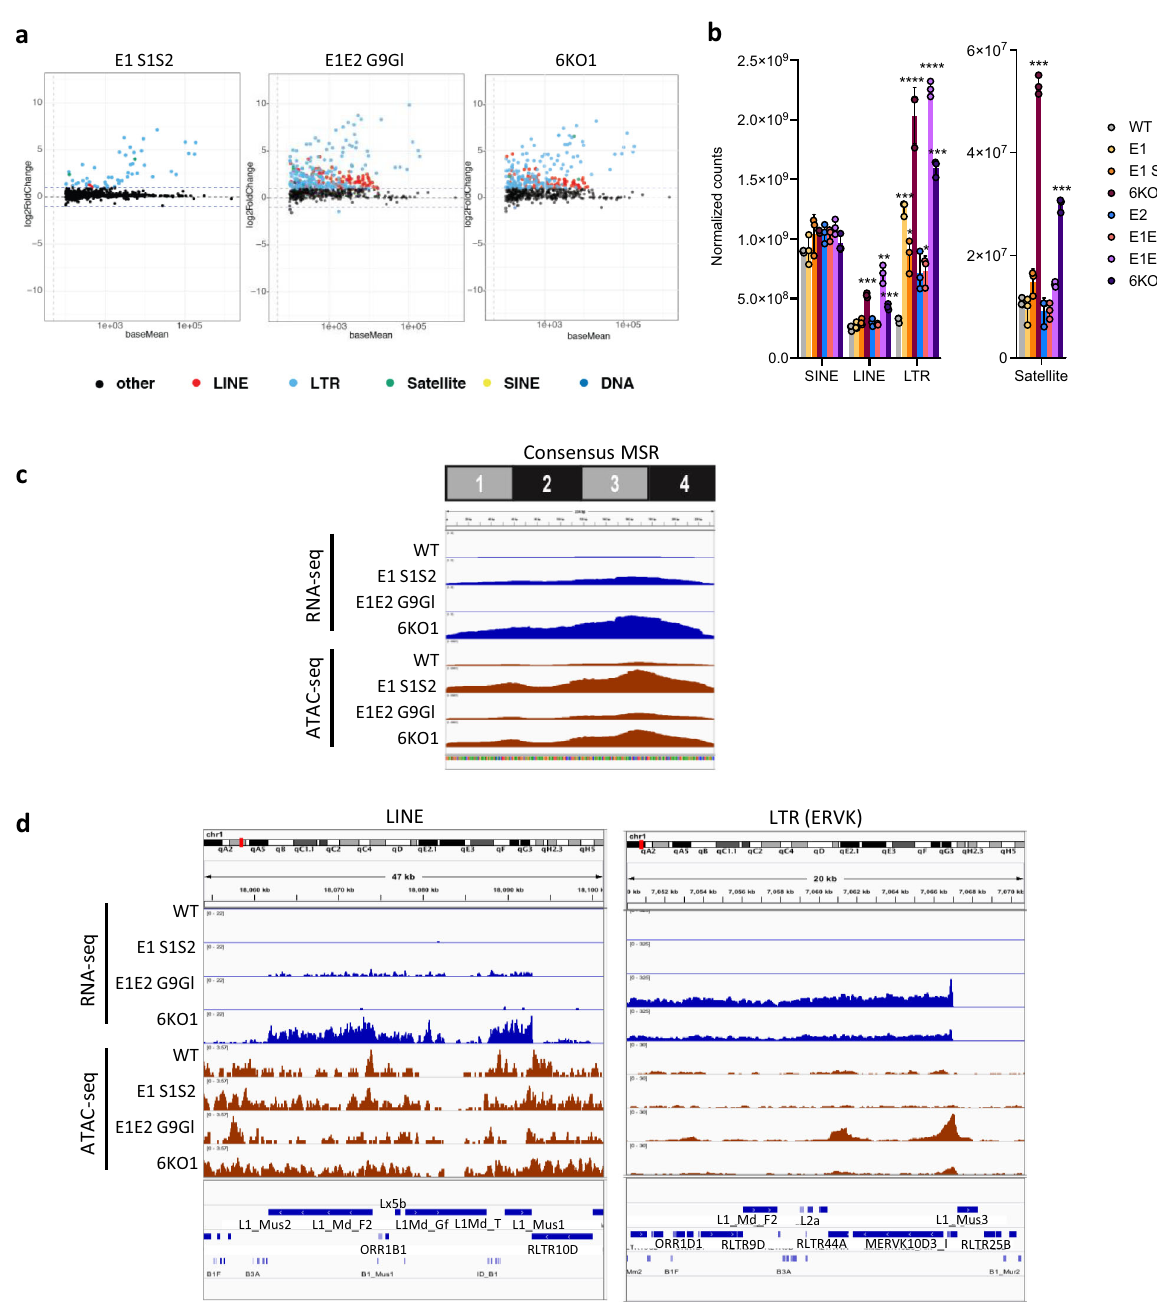
Fig. 3 Massive derepression of repeat elements in compound H3K9 KMT-mutant MEF cells. a MA plots depicting changes in repeat element expression in compound H3K9 KMT mutants relative to WT, as determined by RNA sequencing (RNA-seq). From left to right: E1 S1S2, E1E2 G9Gl , and 6KO1 . Black dots represent repeat elements whose change in expression is not statistically signi fi cant. Red, LINE elements. Light blue, LTR retrotransposons. Green, Satellites. Yellow, SINE elements. Dark blue, DNA transposons. b Global changes in expression for distinct repeat classes (SINE, LINE, LTR, and Satellite), in each of the compound H3K9 KMT mutants. The y axis indicates normalized read counts (mean ± SD, individual data points overlaid, N = 3 independent samples). Satellites are shown on a separate graph due to their lower expression level. Asterisks indicate statistically signi fi cant differences when compared to WT levels (LINE: *** P = 1.1 × 10 − 4 for 6KO1 , ** P = 0.006 for E1E2 G9Gl , *** P = 8.0 × 10 − 4 for 6KO2 ; LTR: *** P = 3.7 × 10 − 4 for E1 , * P = 0.019 for E1 S1S2 , **** P = 6 × 10 − 5 for 6KO1 , * P = 0.026 for E1E2 , **** P = 8.4 × 10 − 5 for E1E2 G9Gl , *** P = 3.6 ×10 − 4 for 6KO2 ; Satellite, *** P = 1.2 × 10 − 4 for 6KO1 and P = 1.4 × 10 − 4 for 6KO2 , two-sided, unpaired t test). c Coverage plot of major satellite repeat (MSR) transcripts to the consensus MSR sequence in WT and H3K9 KMT mutants (from top to bottom: E1 S1S2 , E1E2 G9Gl , and 6KO1 ). ATAC-seq indicating DNA accessibility in the same mutants is shown below. d Genome browser tracks showing expression levels (top) and ATAC-seq pro fi les (bottom) of example genomic regions with repeat elements. Left, genomic region harboring LINE elements. Right, region with LTR-containing elements